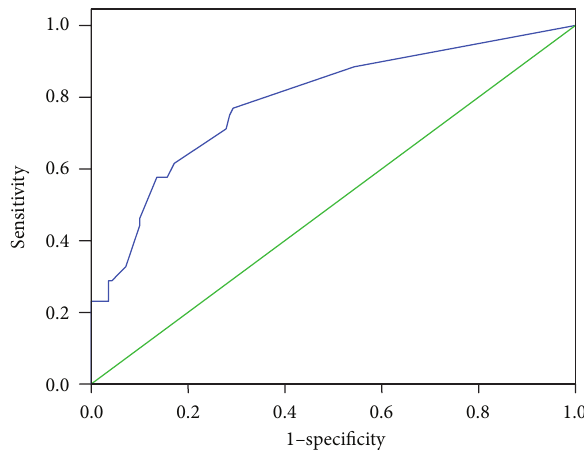
Figure 1: Analysis using the ROC curve showed that the area under the curve using SNAP II scores for Group 1 was 0.78 (CI 95% 0.71–